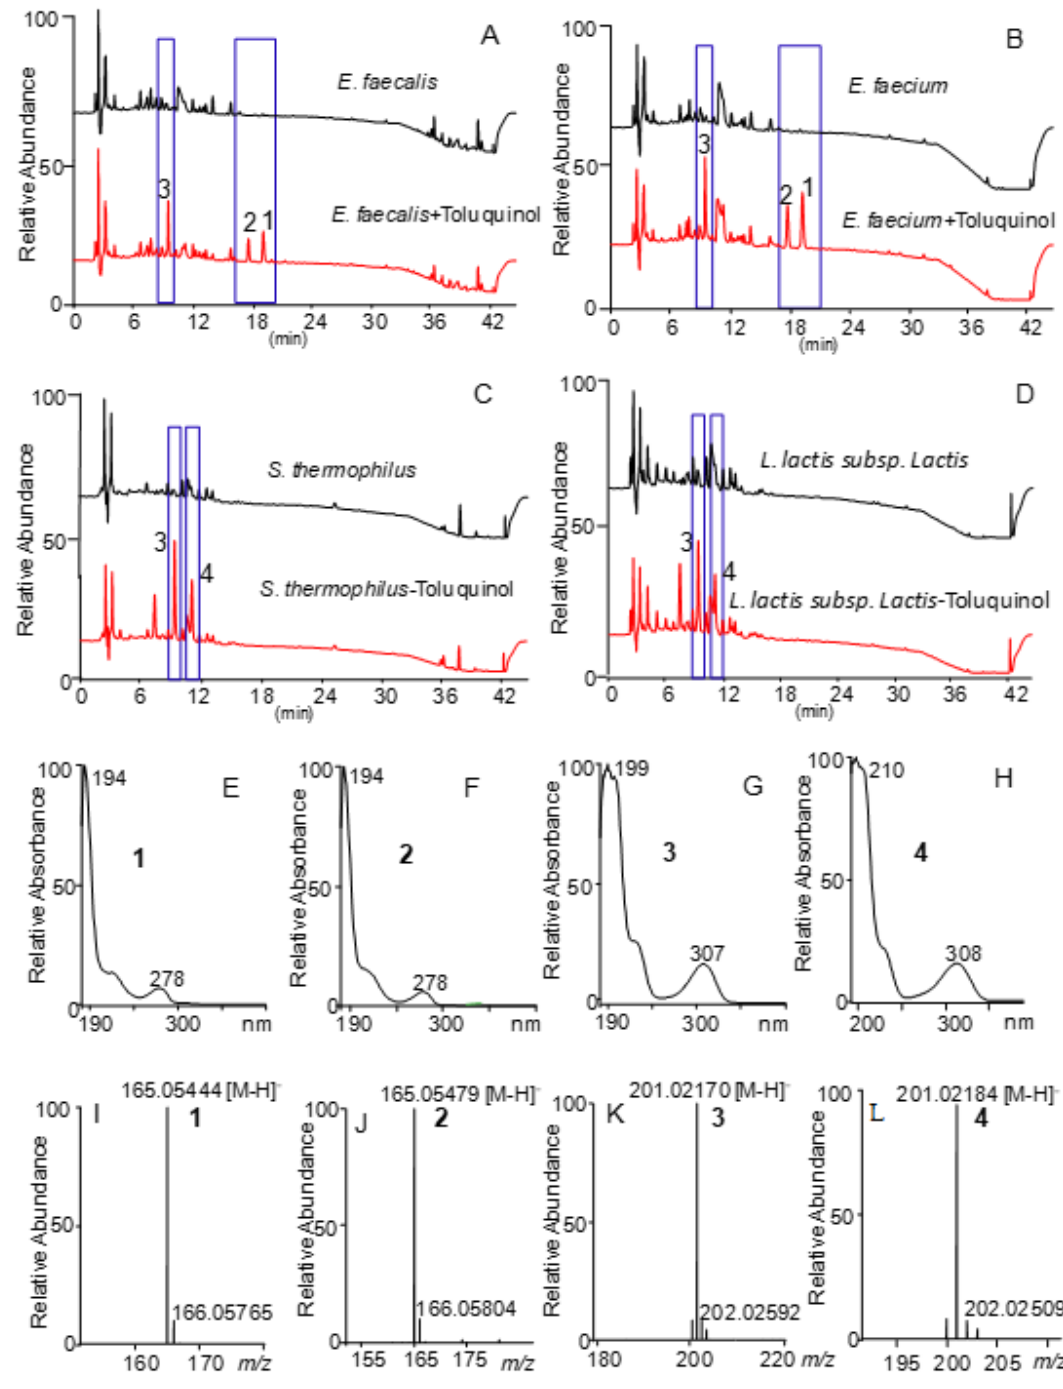
Figure 2. Transformation of toluquinol in four gut microbes. ( A – D ) Comparison of metabolic profiles of E. faecalis , E. faecium , S. thermophilus , and L. lactis subsp. Lactis fed with and without